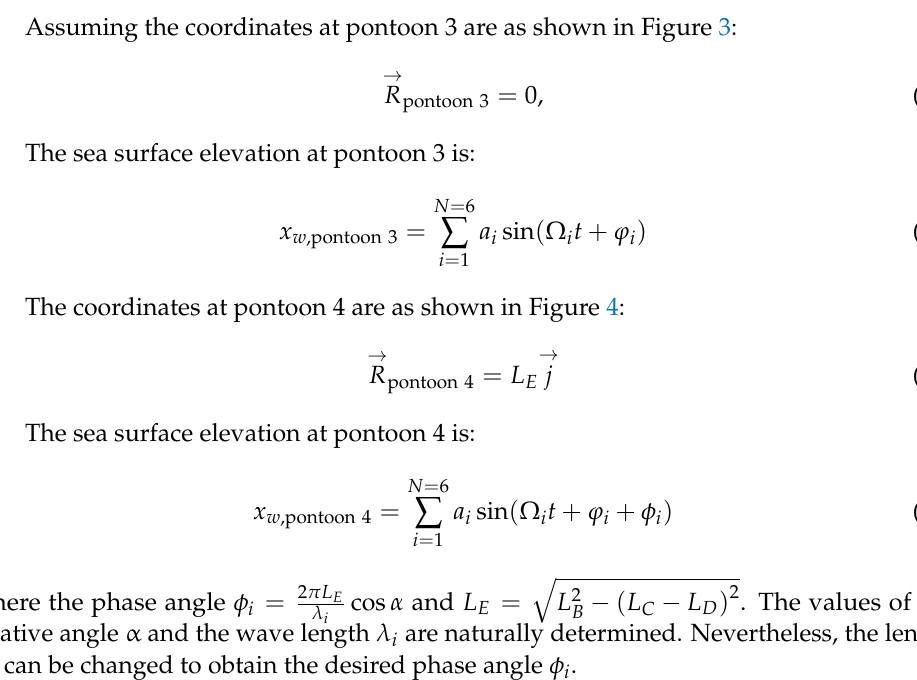
Figure 4. Relation among phase f i , wave length λ i and relative direction α of wave and current and distance L E between the two pontoons.